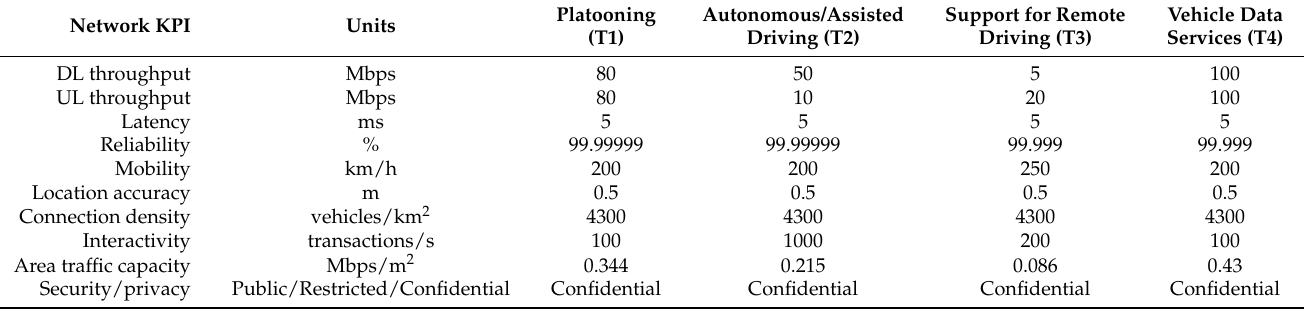
Table 2. 5G-HEART Vehicular Services’ Network Key Performance